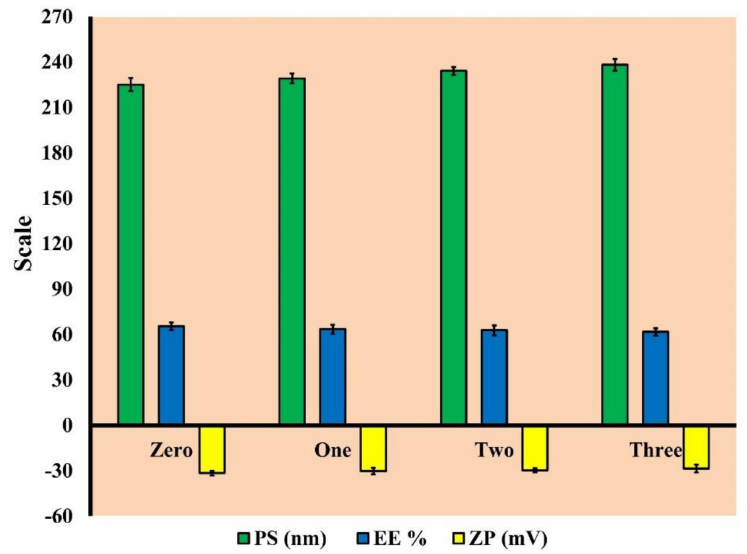
Figure 7. The PS, EE and ZP of the optimized formulation (GS-CBS) after three months of storage.